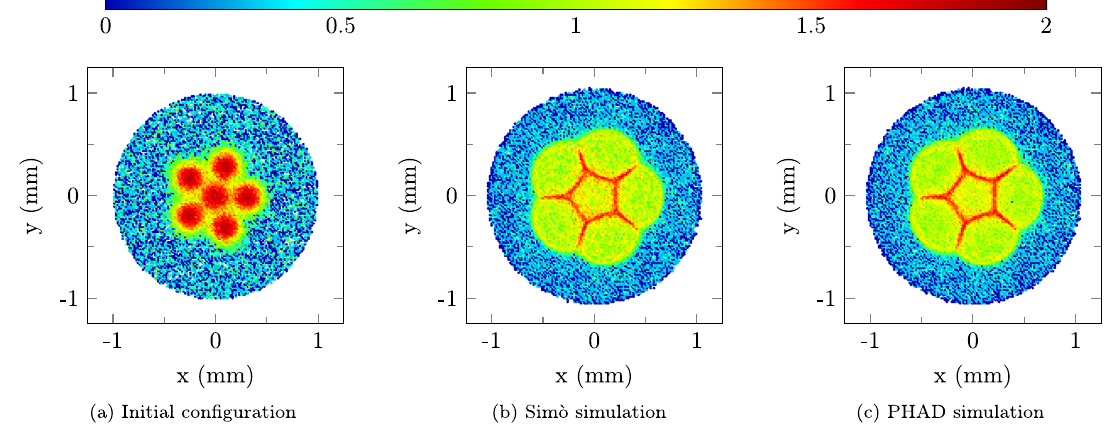
FIG. 8. Density log plots of the cross-section of six beamlets each consisting of 10 4 electrons Gaussian distributed, and surrounded by a halo of 2 × 10 4 uniformly distributed electrons: (a) initial condition, and the results after t ¼ 1 . 7 ns of: (b) the standalone Simò integrator simulation and (c) PHAD simulation.